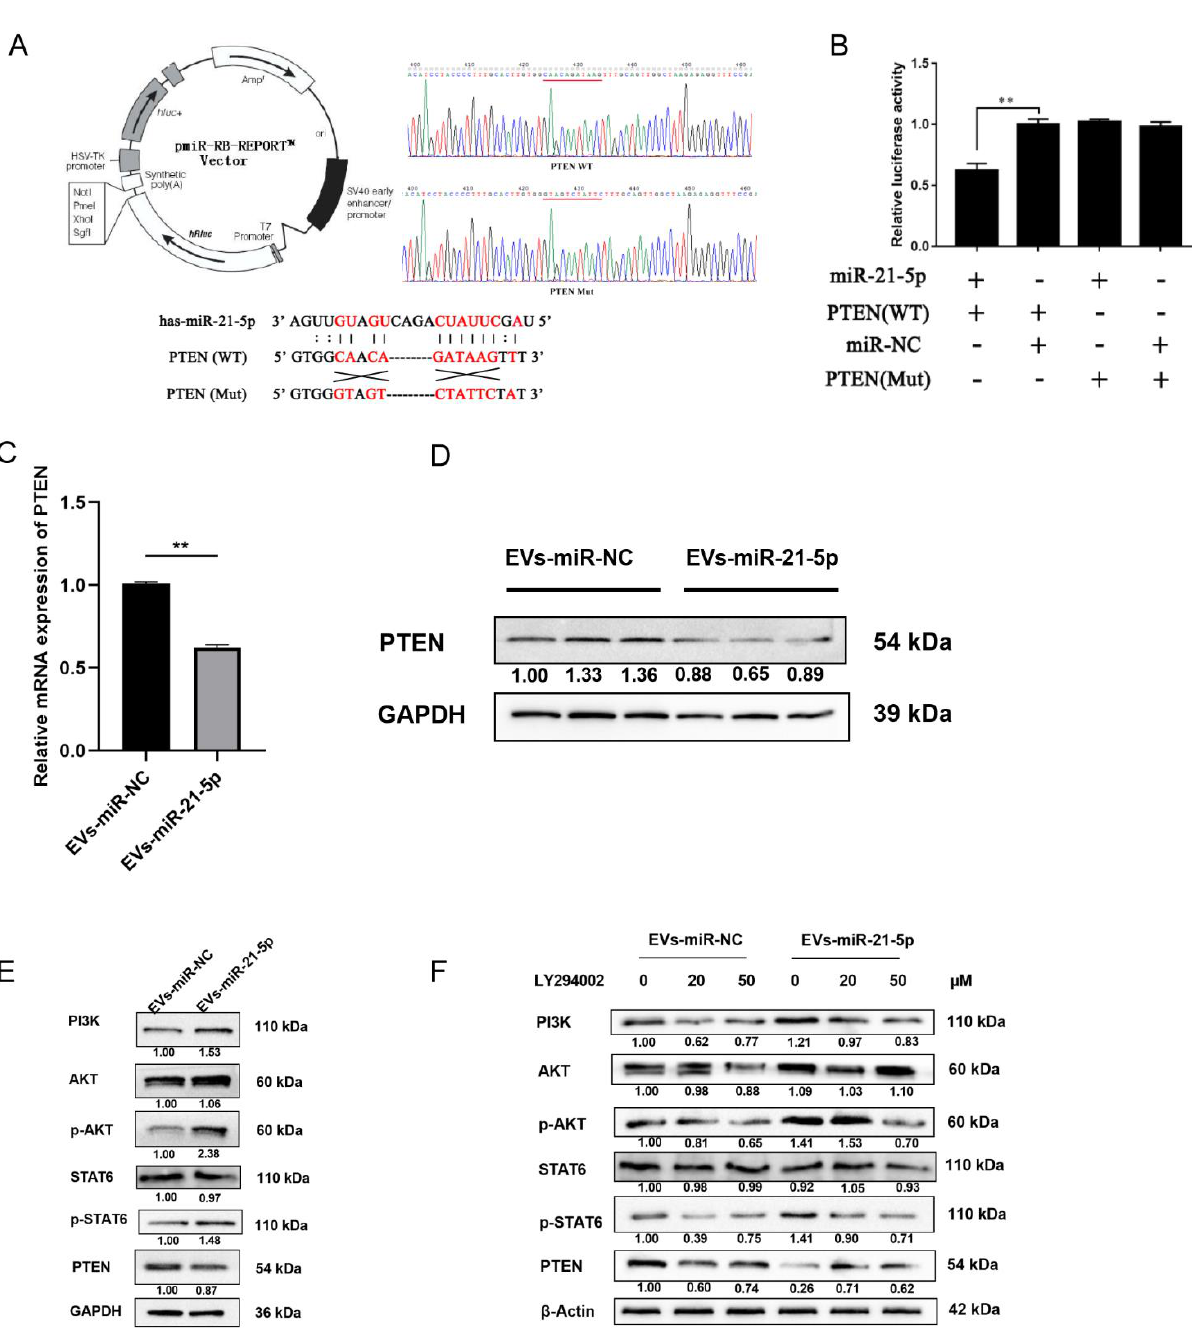
Figure 5. EVs-miR-21-5p activates M2 macrophage polarization via the PTEN/PI3K/AKT/STAT6 axis. ( A ) Plasmid vector pattern and region binding site of PTEN. The presence of the mutation in the 3 (cid:48) UTR was confirmed via DNA sequencing ( B ) THP-1 cells were respectively transfected for 48 h with pCDNA-PTEN-WT and pCDNA-PTEN-Mut or with miR-21-5p mimics and mimics-NC. The mRNA ( C ) and protein ( D ) levels of PTEN in EVs-miR-21-5p-treated macrophages. ( E ) Western blotting analysis of PI3K, STAT6, p-STAT6, Akt, p-Akt, and PTEN expression in PMA-treated THP-1 cells transfected with EVs-miR-21-5p. ( F ) Relative protein levels of the PTEN/PI3K/AKT/STAT6 axis after LY294002 treatment. The relative protein level was normalized to that of β -actin or GAPDH. The F - or t -test was applied to assess statistical significance in group comparisons; ** p < 0.01. Error bars indicate mean ± SD. EVs- miR-NC, EC109 cells were transfected with miRNAs mimic-NC for 48 h and cocultured with PMA-treated macrophages for another 24 h. EVs-miR-21-5p, EC109 cells were transfected with miR-21-5p mimic for 48 h and cocultured with PMA-treated macrophages for another 24 h. The uncropped Western Blot images can be found in Supplementary Materials.